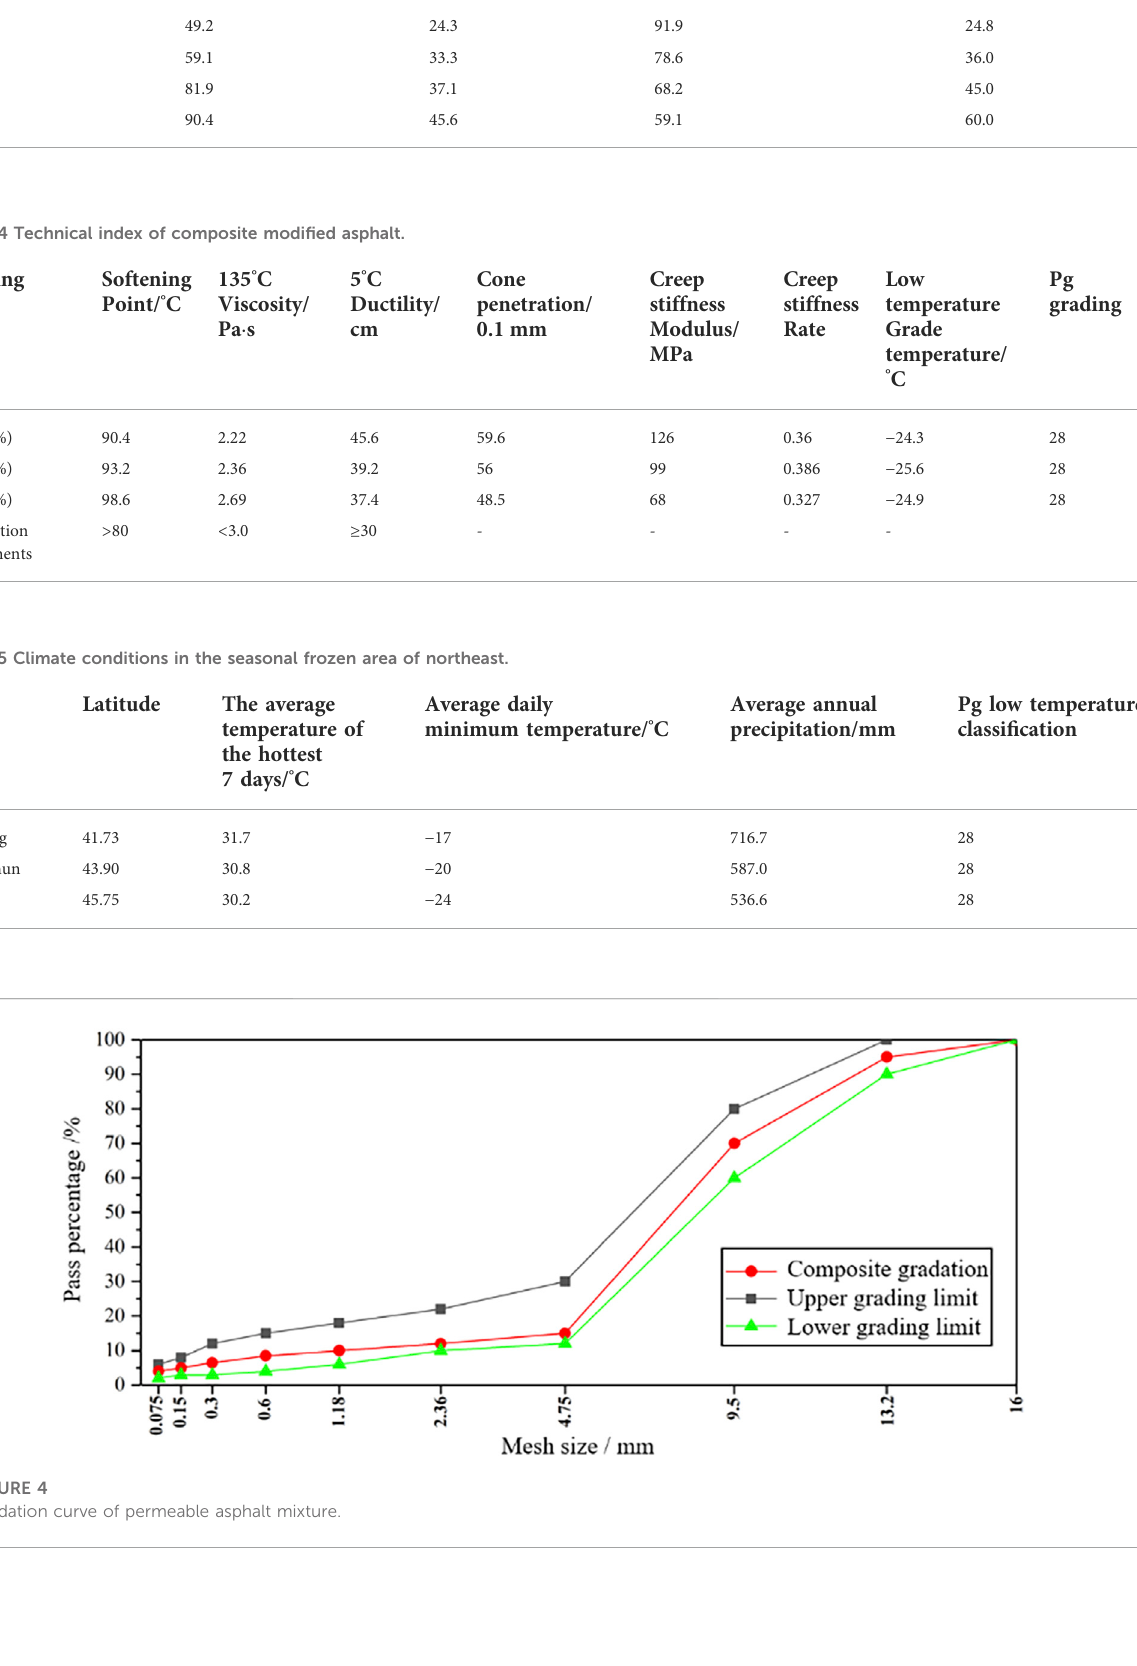
TABLE 3 Viscosity index and test results of asphalt with different high-viscosity modi fi ers. Blending ratio (%)